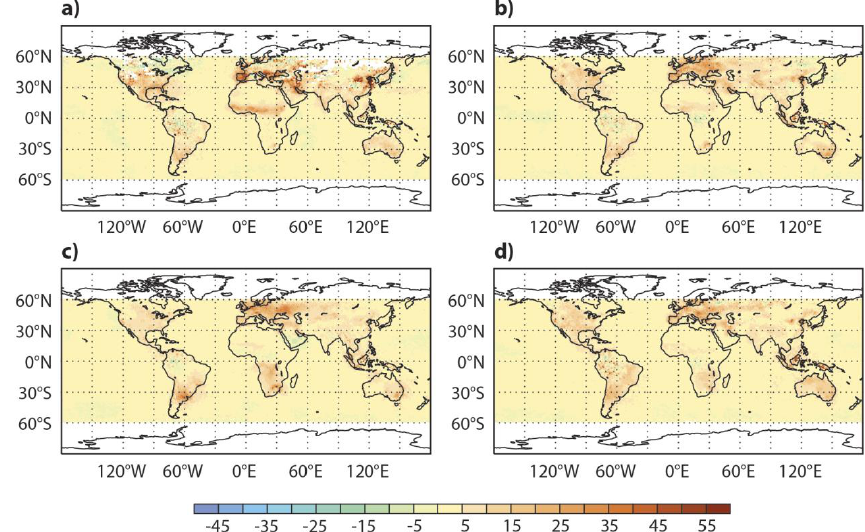
Figure 18. OMI TRCNO2 analysis increment (analysis minus forecast) in % from CIFS-AN averaged over (a) JF, (b) MAM, (c) JJA and (d) SON 2008. Red indicates positive values, blue negative values.